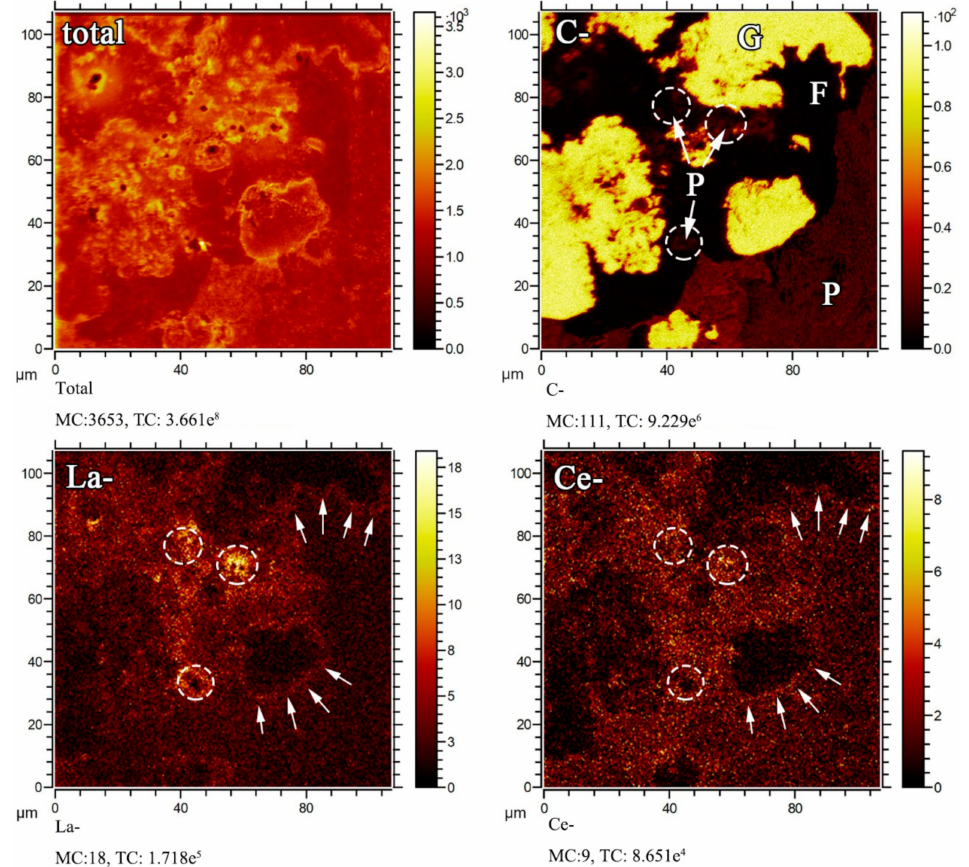
Figure 7. SIMS images and distribution of La and Ce in CGI